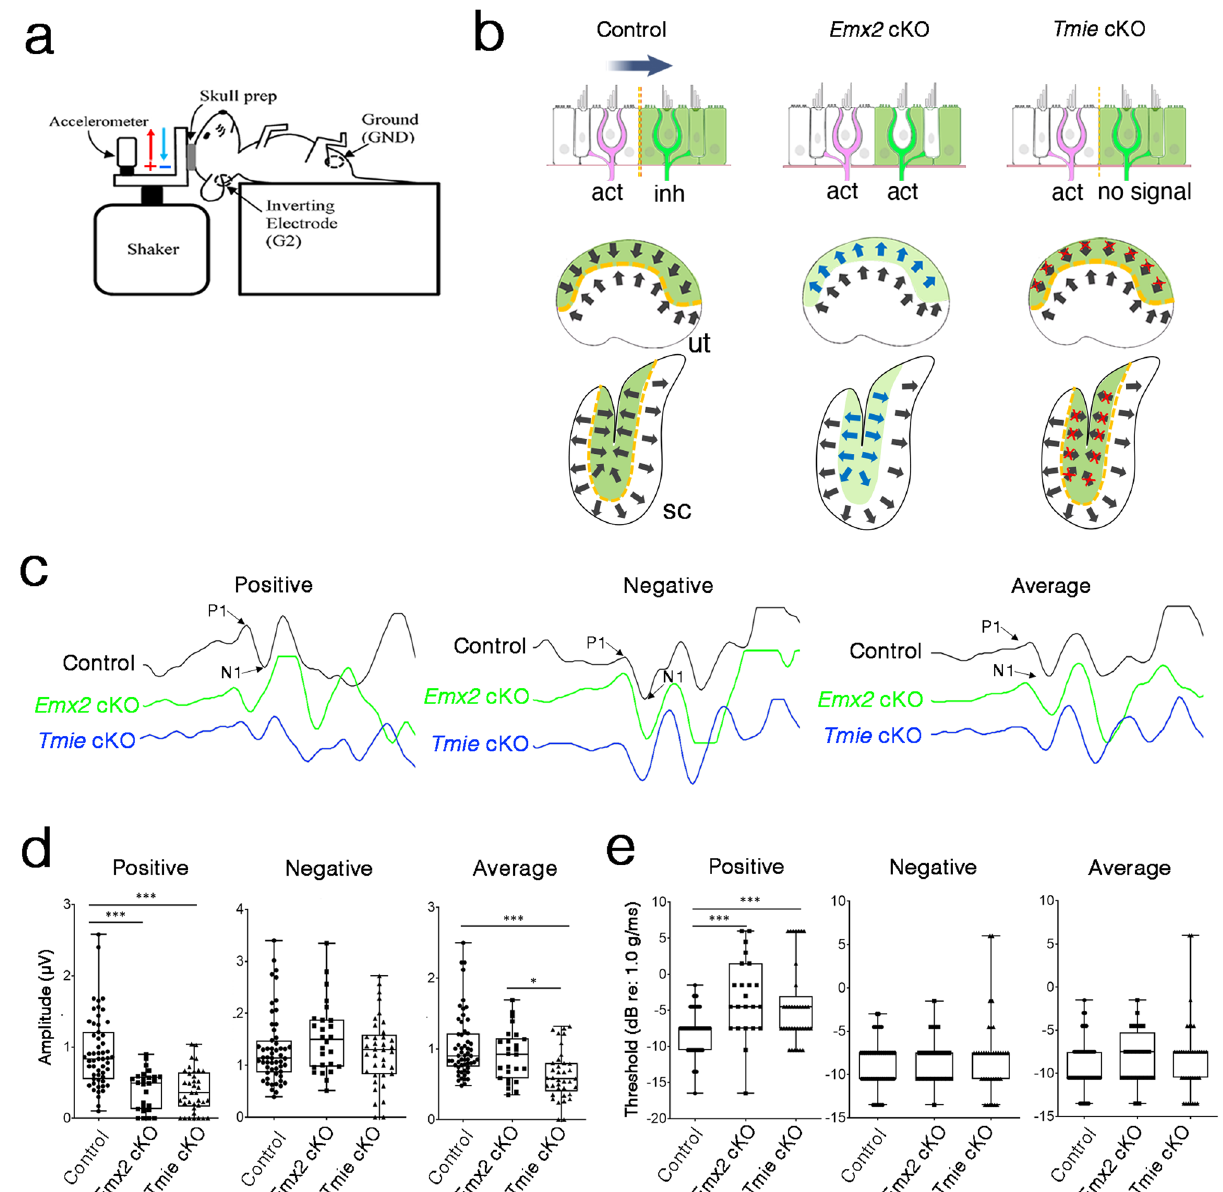
Fig.8|ReducedamplitudesandincreasedthresholdsofVsEPin Emx2 cKOand Tmie cKO mice. a Schematic diagram of the apparatus for VsEP measurement (ReprintedfromJones,T.A.&Jones,S.A.Shortlatencycompoundactionpotentials from mammalian gravity receptor organs. Hear. Res . 136 , 75 – 85 (1999). Copyright (1999),withpermissionfromElsevier).Redarrowindicatesthedirectionofpositive stimulationtowardsthenose,andthebluearrowindicatesthedirectionofnegative stimulation towards the occipit. b Hair bundle orientation of the maculae and neural responses to a directional stimulus (large gray arrow) in the utricle of con- trols, Emx2 cKO and Tmie cKO. c VsEPwaveforms at maximal jerk stimulus (+6dB) d Summary of VsEP amplitudes measured at maximal jerk stimulus (+6dB) of positive and negative directions of stimulation, and average of the two stimulus directions.Bothmutantsshowloweramplitudesinpositivedirectionofstimulation